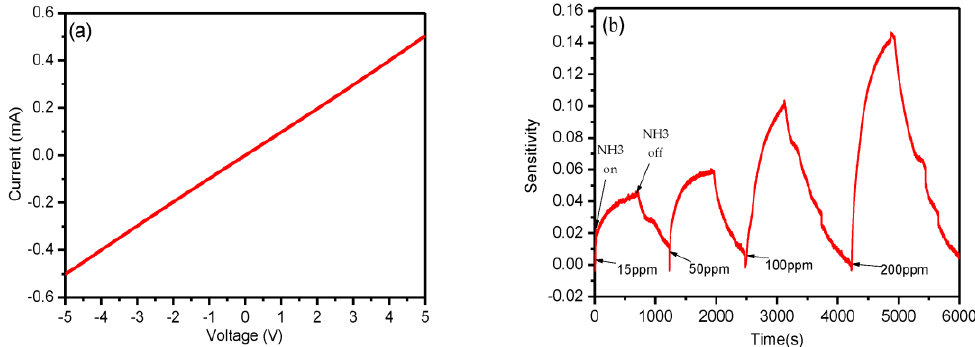
Figure 10. ( a ) Current–voltage (I-V) curves for the coated IDEs with rGO/Ag-ink; ( b ) dynamic response of the IDEs sensors to different concentrations of NH 3 at room temperature. [50].